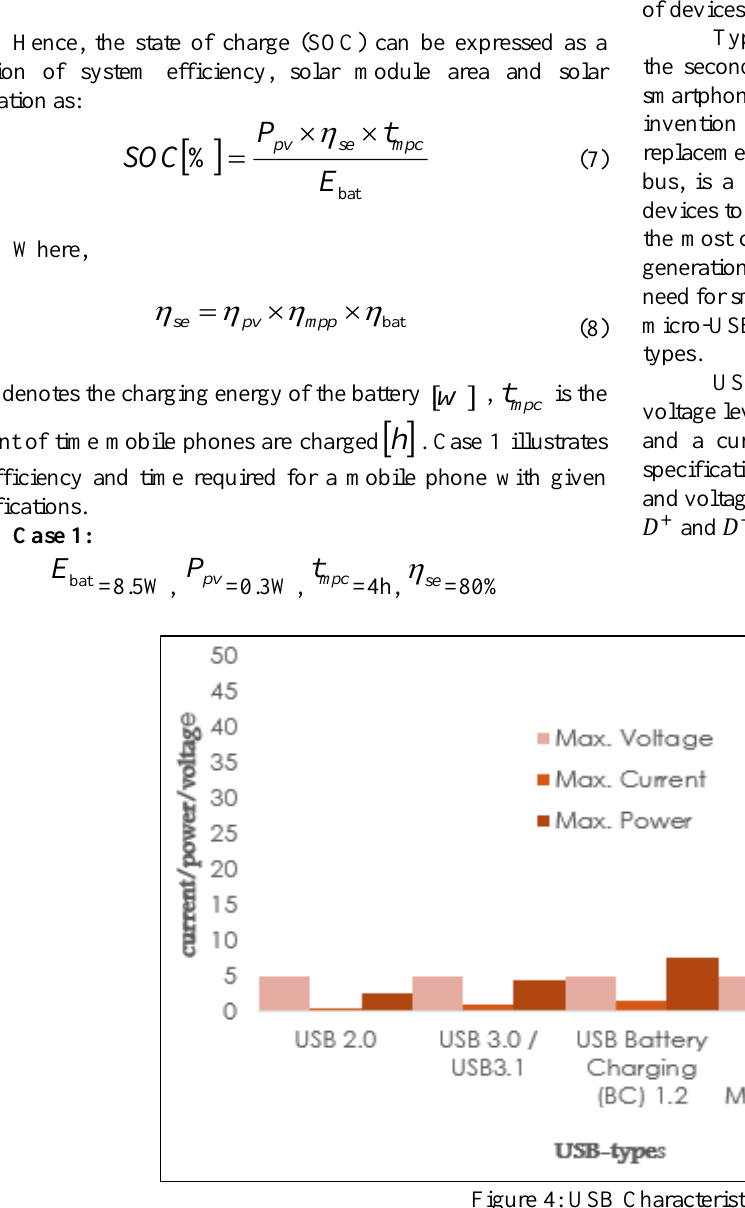
converts solar energy to electricity. The study uses a 50W, 17.5V monocrystalline solar panels.. Tier-2 is in charge of power Figure.5 is the conceptual framework of the proposed off- conversion and ensuring maximum power output. The charge grid charging systems. The systems feature six-tiers. Tier-1 controller unit is in Tier 3. This is a power regulator that optimizes consists of a solar PV system, which is an energy harvester that the amount of power that the PV module sends to the battery in